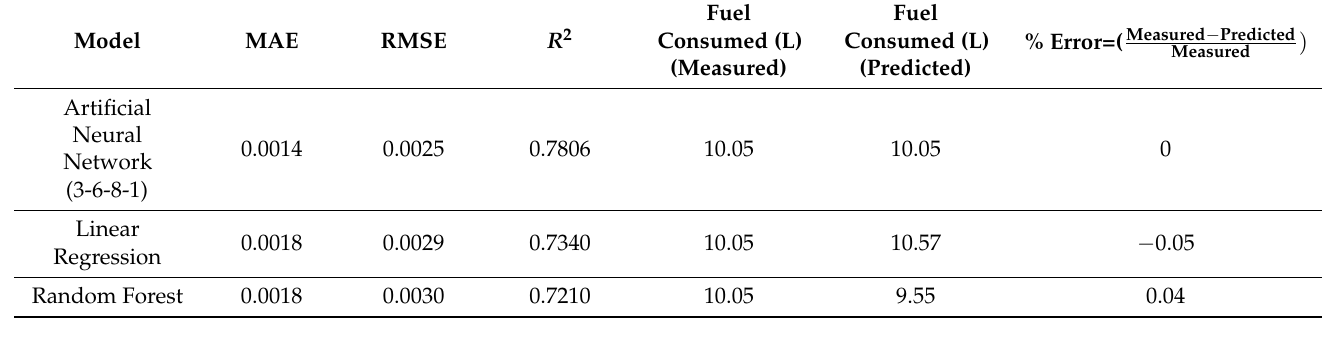
Table 2. Comparison of performance on test dataset.